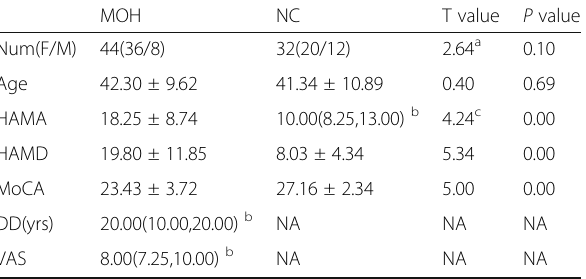
Table 1 The clinical characteristics of MOH patients and normal